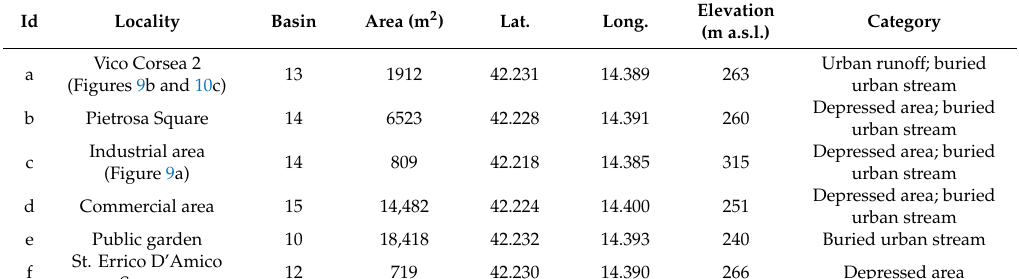
Table 5. Urban critical areas due to the convergence of surface runo ff .